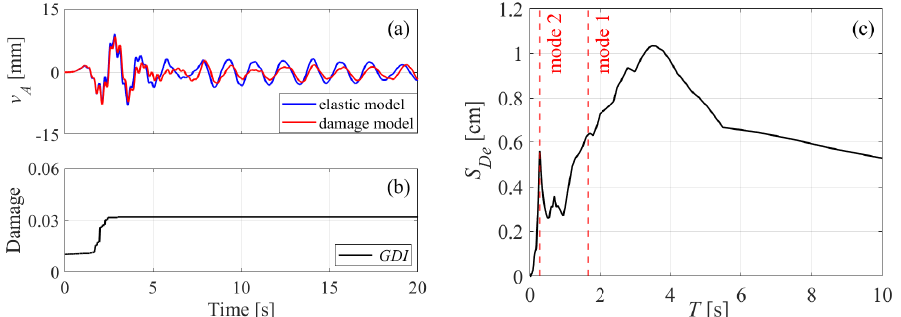
Figure 9. Earthquake FORC station: ( a ) elastic and damage responses of the equivalent pier, ( b ) evolution of the GDI , ( c ) elastic displacement spectrum.